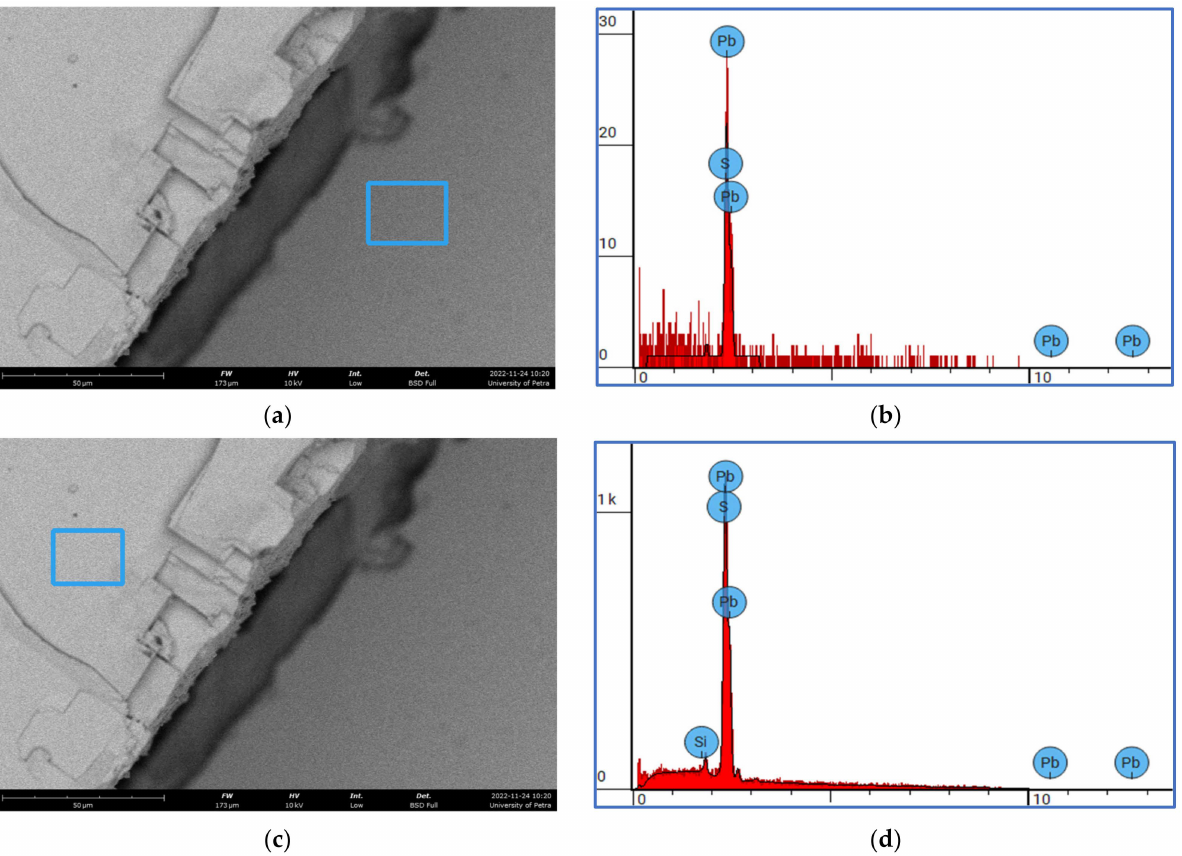
Figure 4. ( a ) SEM micrograph (BSI), fractured surface of the as-received galena, ( b ) the EDS spectrum for the blue square in ( a ), ( c ) the other side of the fractured surface, ( d ) the EDS spectrum of the blue square in ( d